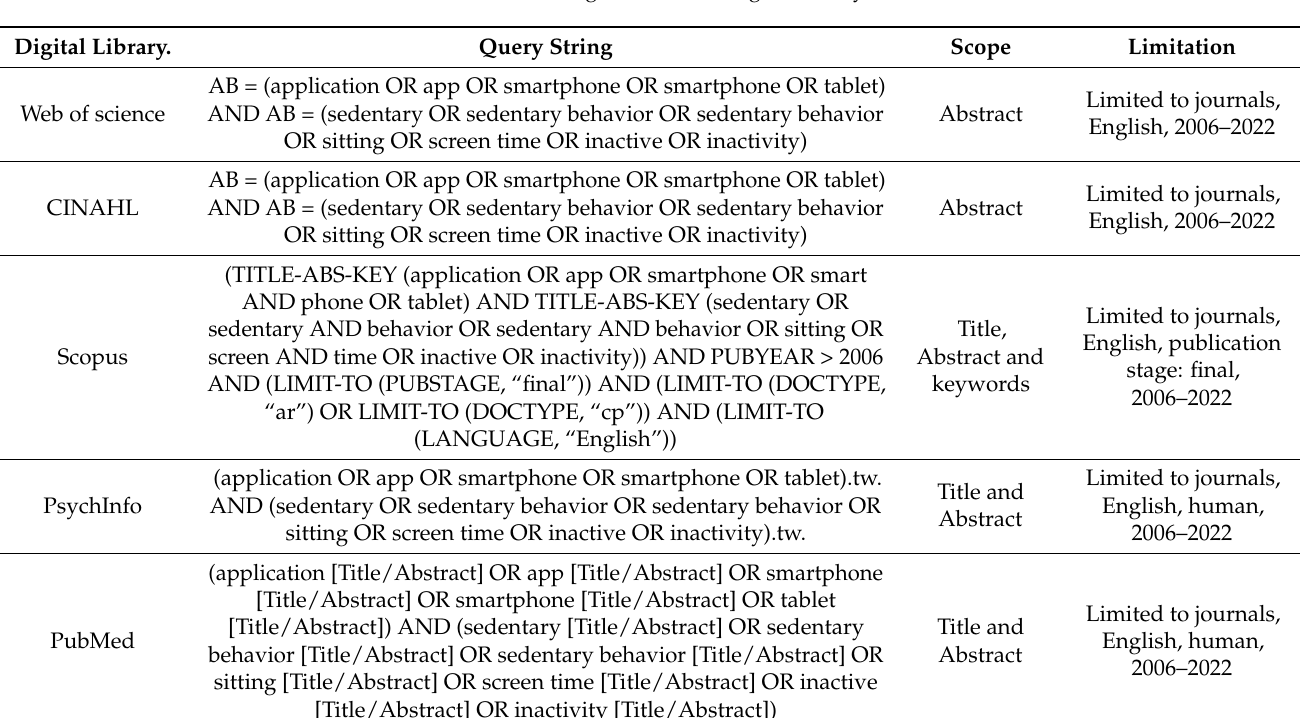
Table 3. List of search strings in different digital